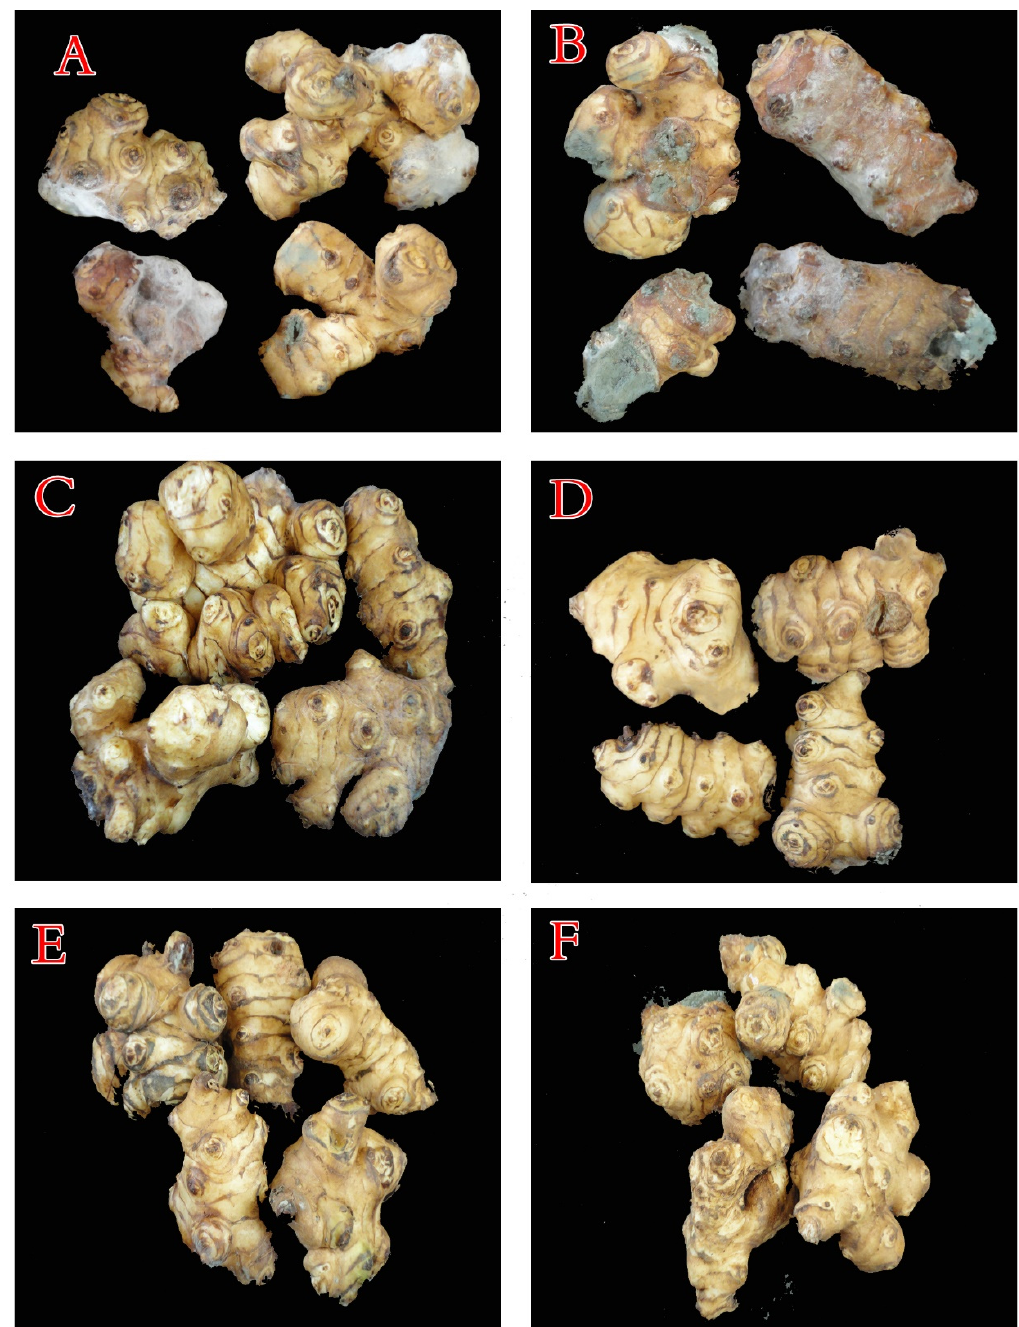
Figure 9. Effect of clove and caraway essential oils on control of JA tuber decay caused by P. polonicum under storage conditions at 25 °C after 2 months. ( A ) = untreated control (C), ( B ) = untreated and infected by P. polonicum (ARS20), ( C ) = treated with caraway oil (CR), ( D ) = treated with clove oil (CL), ( E ) = treated with caraway oil plus infection by P. polonicum (CRP) and ( F ) = treated with clove oil plus infection by P. polonicum (CLP).